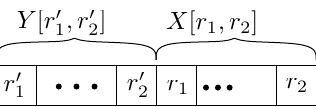
] followed by a maximal stable communication , r (cid:48) 2 1